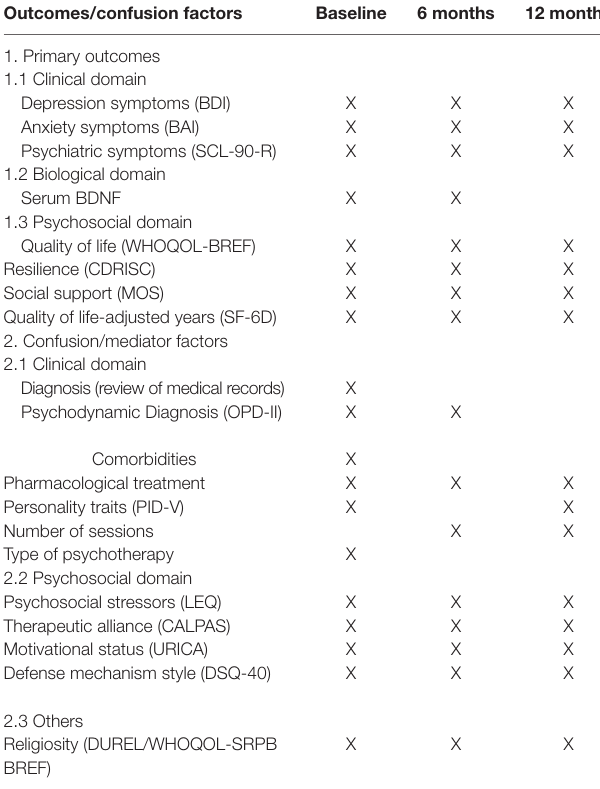
TABLE 1 | Assessments according to time of